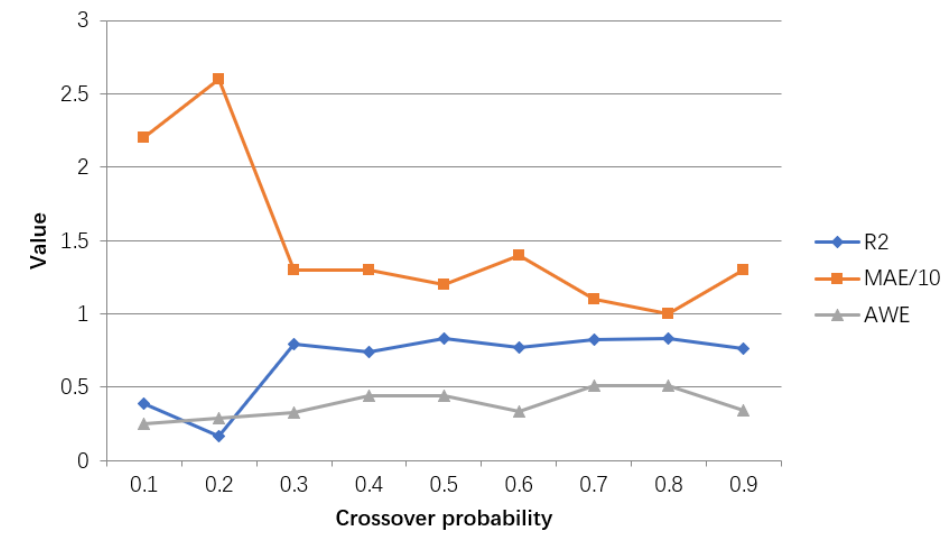
Figure 15. Line chart of the adjustment results of the crossover probability of the hyperparameters in the GA-BP model. The value represents results for R2, MAE/10, AWE for different parameters